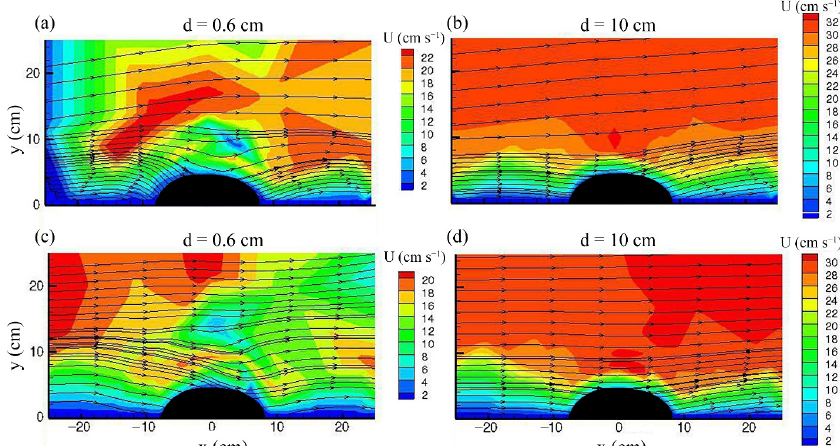
Figure 5. Streamlines around the abutment ( a , b ) for the un-vegetated bed and ( c , d ) for the vegetated bed at two heights of d = 0.6 cm and d = 10.0 cm from the stabilized scour bed. Note that the range of the color scale is not equalized for better illustration.